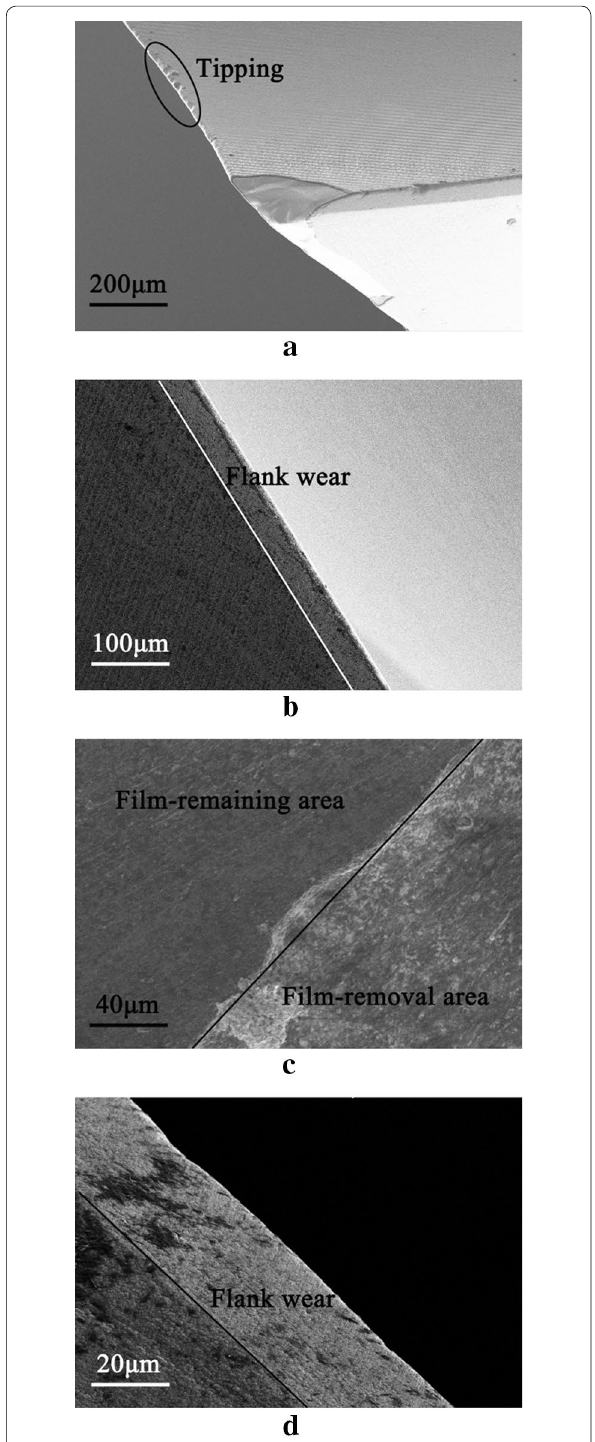
Figure 10 Typical wear or failure modes for typical specimens: a the abnormal but expected tipping of one F‑WC specimen; b the normal flank wear of one F‑WC specimen; c the film removal of the AFM‑UFGD specimen; d the slow flank wear of the AFM‑BDM‑UFGCD